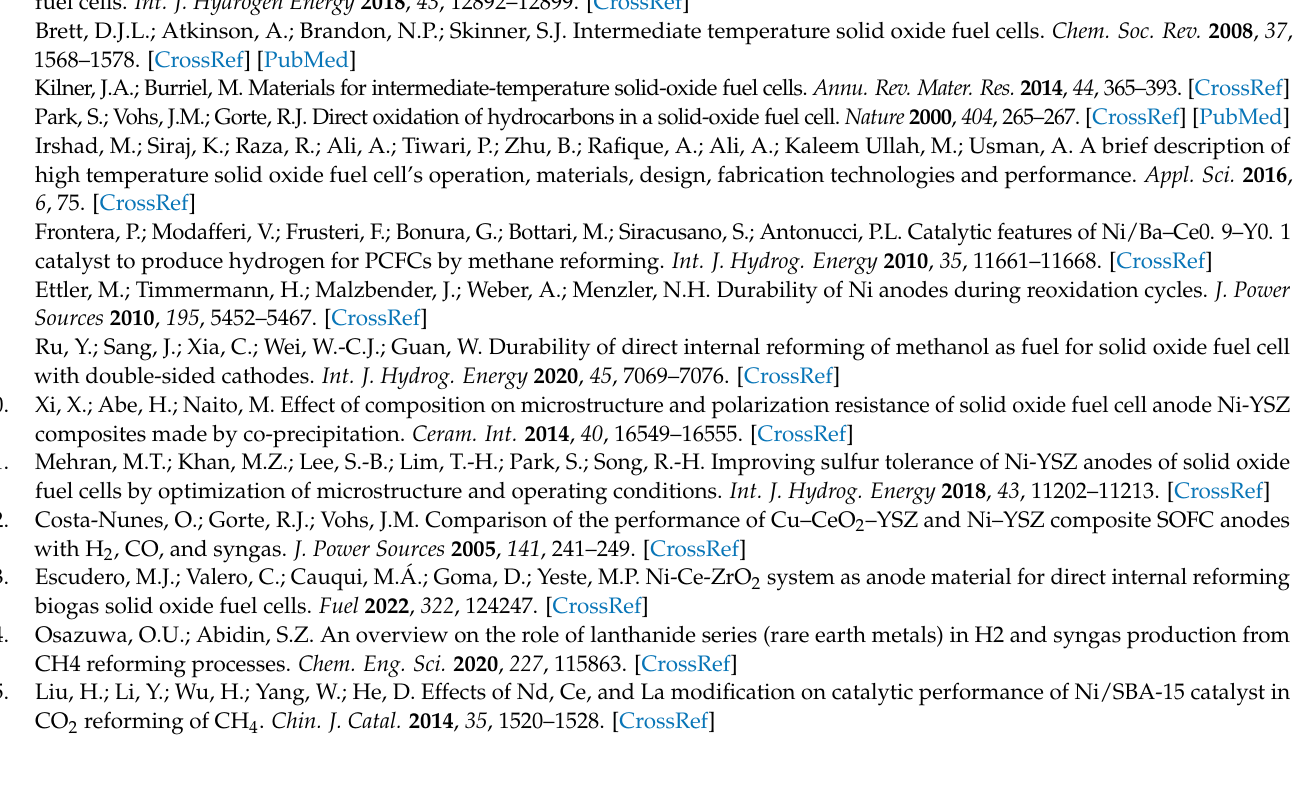
Figure S4:TEM image of doped catalysts after ATR of methane at T = 800 ◦ C and GSHV = 120,000 h − 1 . Figure S5: TEM image of undoped catalysts after ATR of propane at T = 800 ◦ C and GSHV = 120,000 h − 1 . Figure S6: Reactors after endurance tests of undoped NiCZ80 and doped NidpCz80. The presence of coke is evident for the undoped NiCZ80